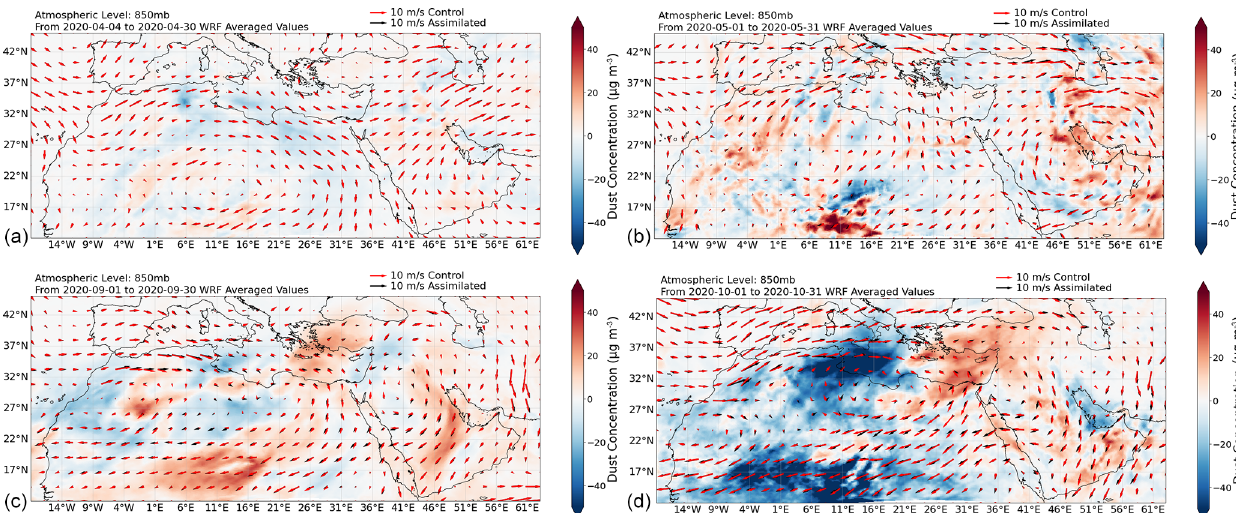
Figure 1. Depiction of the difference in monthly average dust concentration and of wind vectors between the assimilated and control datasets, averaged for spring months ( a , April, b , May) and autumn months ( c , September, d , October) for the atmospheric pressure level of 850mbar, where the red arrows represent the control wind vectors and the black arrows the assimilated ones.